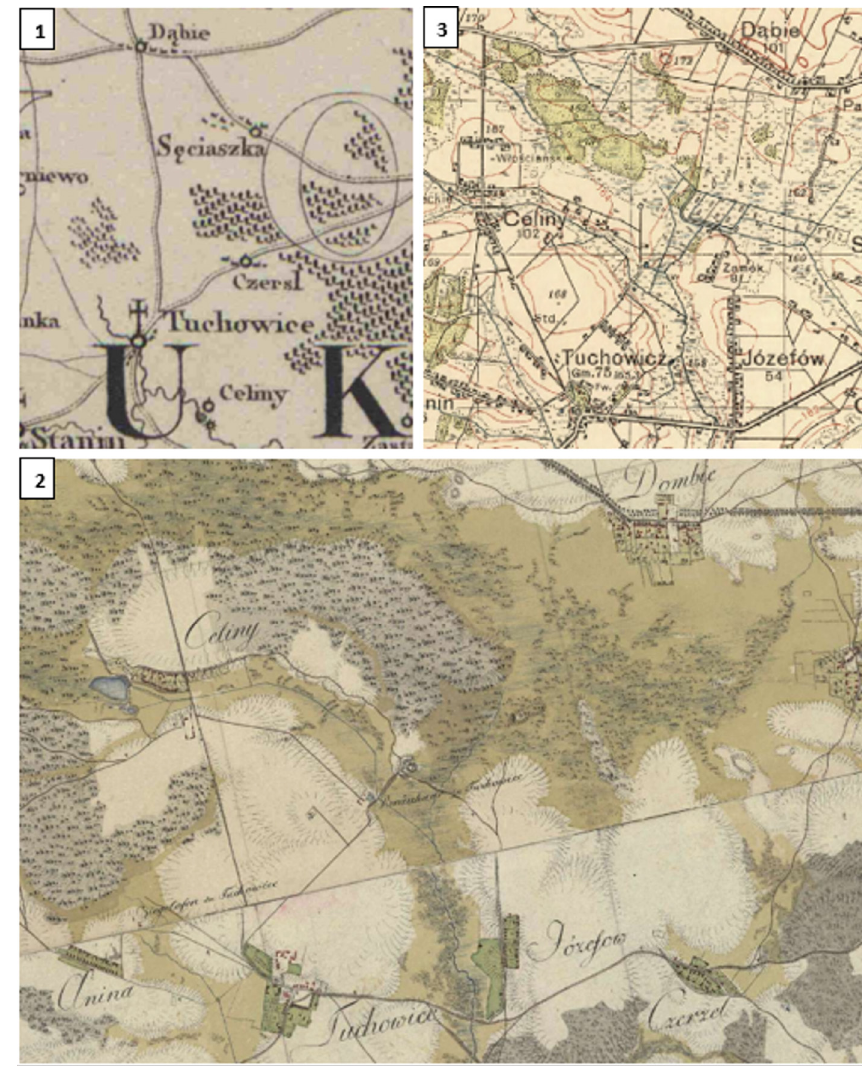
Fig. 5. Differences in the presentation of the road connecting villages Tuchowicz and Dąbie: 1 – a part of the Special Map of the Lublin Voivodship of C. Perthées (1:225,000, 1786), 2 – a part of the Heldensfeld’s Map of Western Galicia (1:28,800, 1804), 3 – a part of the MGI Tactical Map (1:100,000,